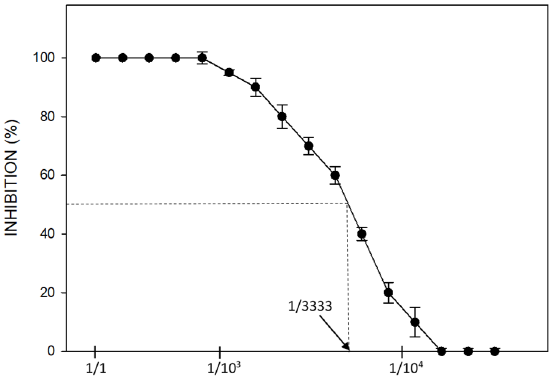
Figure 3. Effect of AMD-1 at different dilutions on seedling development. Dilution ratio is indicated as 1/X where X is the final volume after dilution.